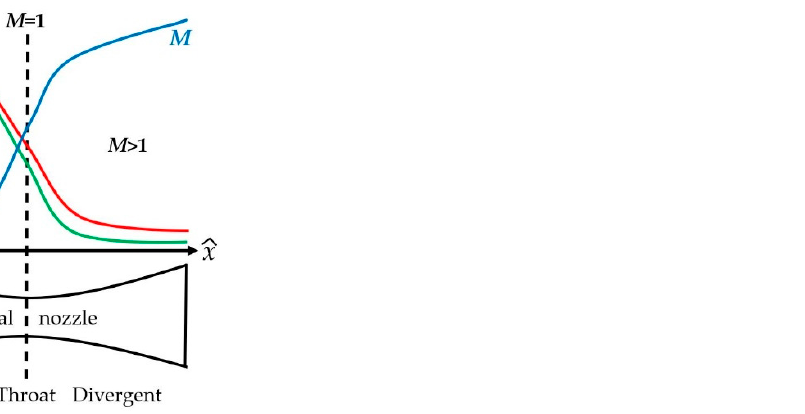
Figure 3. The estimated pressure ( P ), temperature ( T ), and Mach number ( M ) of a gas flow inside the de Laval nozzle.